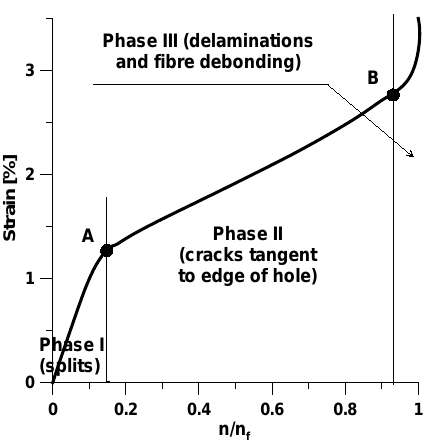
Figure 13. The strain-life curve for structures with holes; the strain corresponds to the total strain of